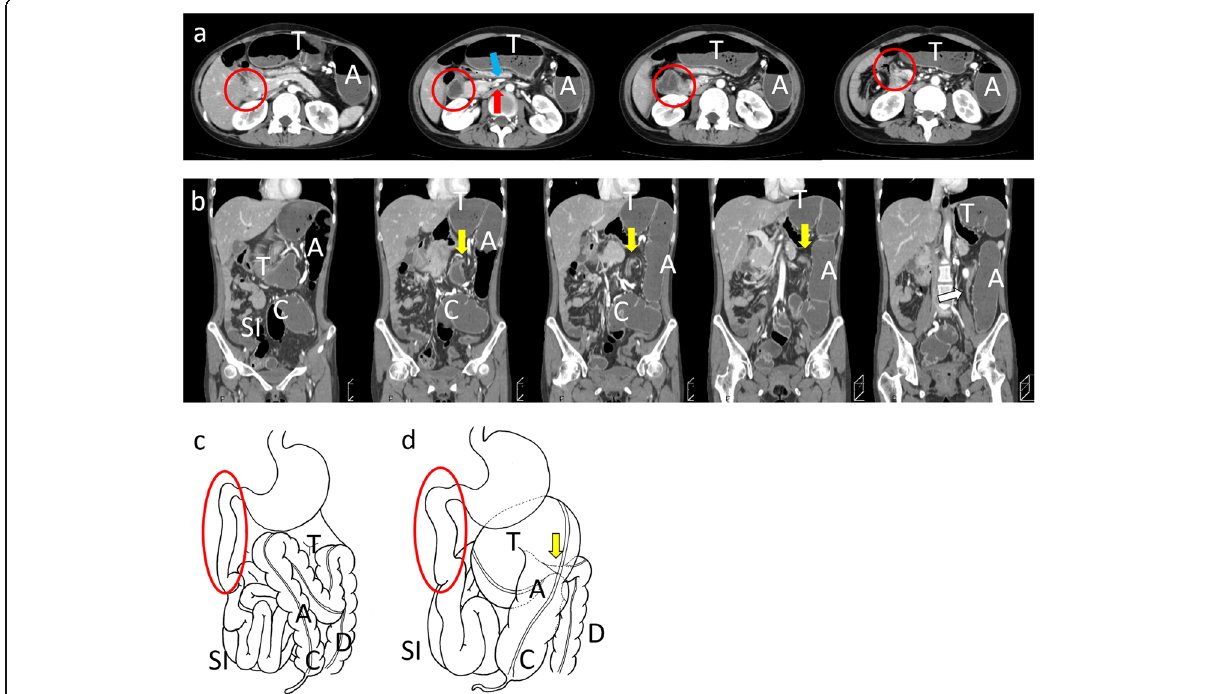
Fig. 1 Enhanced computed tomography before the first surgery. Transverse section ( a ) and coronary section ( b ) images show the enlarged transverse colon (T) with an obstructed point at the splenic flexure with a whirlpool sign (yellow arrow). The ascending colon (A), transverse colon (T), and descending colon (D) were located on the left side of the abdominal cavity, and the small intestine (SI) was located on the other side. The cecum (C) inhabited the pelvic cavity. The superior mesenteric artery (red arrow) was located on the right side of the superior mesenteric vein (blue arrow). The duodenum did not cross the vertebral column but traveled down straight (red circle). The drainage veins were dilated, but there were no signs of ischemia. c and d illustrate the gastrointestinal tract of nonrotation and volvulus at the transverse colon before